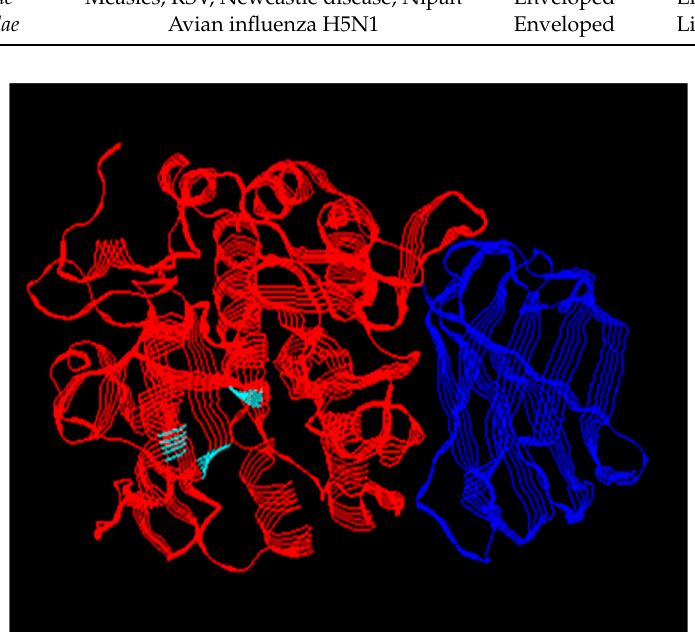
Figure 1. X-ray crystal structure of human furin. The PC catalytic domain (red) shared by all PCs has the structural fold typical of the subtilin family of serine proteases. The position of the catalytic triad residues is marked in cyan. The P domain (blue) regulates catalytic activity. The PCs differ in their additional domains. PDB ID code 5JXH.